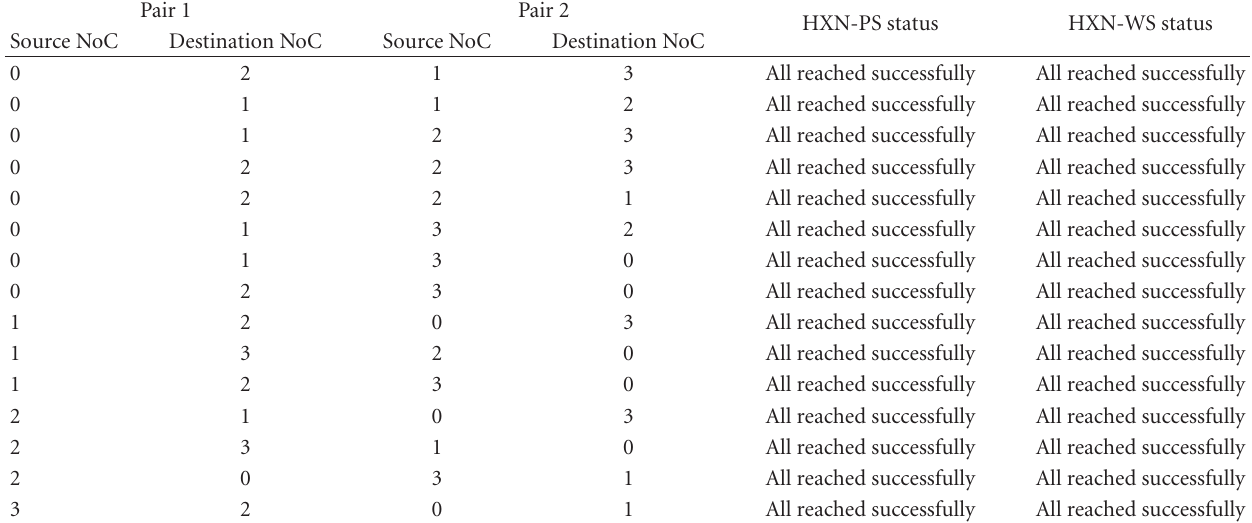
Table 25: The following source destination pairs of NoCs are used to show 100% e ffi ciency of the NiP (based on HXN, used as IoC). All source destination pairs delivered the payload information to the respective NoC. The following data does reflect the parallel communication among the NoCs using packet and wormhole switching